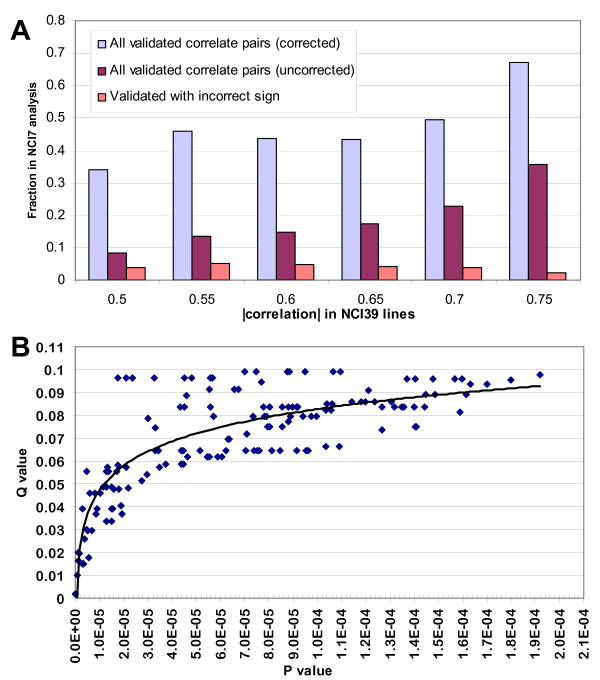
Estimation of the false discovery rate. A) Validation of NCI39 derived gene:drug correlate pairs in the NCI7 cell lines. The percent of pairs which validated increased with the increasing correlation coefficient of the nominated gene-drug relationship in the NCI39 training set, and very few candidates were found to have significant but oppositely signed correlations in the NCI7 data. When the percentage of validated correlates is adjusted by the power of a correlation, assuming a single-sided p value of 0.5 is considered significant with a sample size of six, it becomes apparent that a majority of the gene:drug correlate pairs with correlations greater than 0.7 would have validated in a replication of the original experiment. B) Comparison of q-values and p-values for the gene:drug correlates. To estimate the q value in these very large data sets, random subsets of the gene expression and GI50 data were iteratively compared and the distribution of p values were measured for ~150000 correlations in total. A q value of 0.05 (i.e., that for every 100 significant correlates, five false correlates are expected.) is associated with a p value of approximately 1 × 10-5.